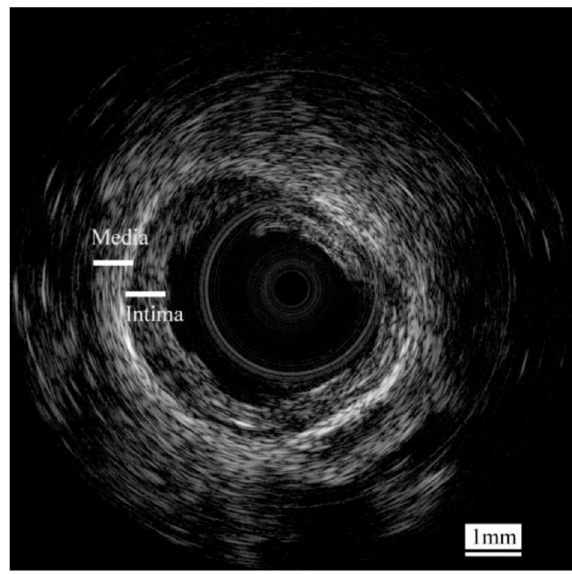
Figure 17. An intravascular ultrasound image acquired from a 0.5BZT–0.5BCT transducer [90].